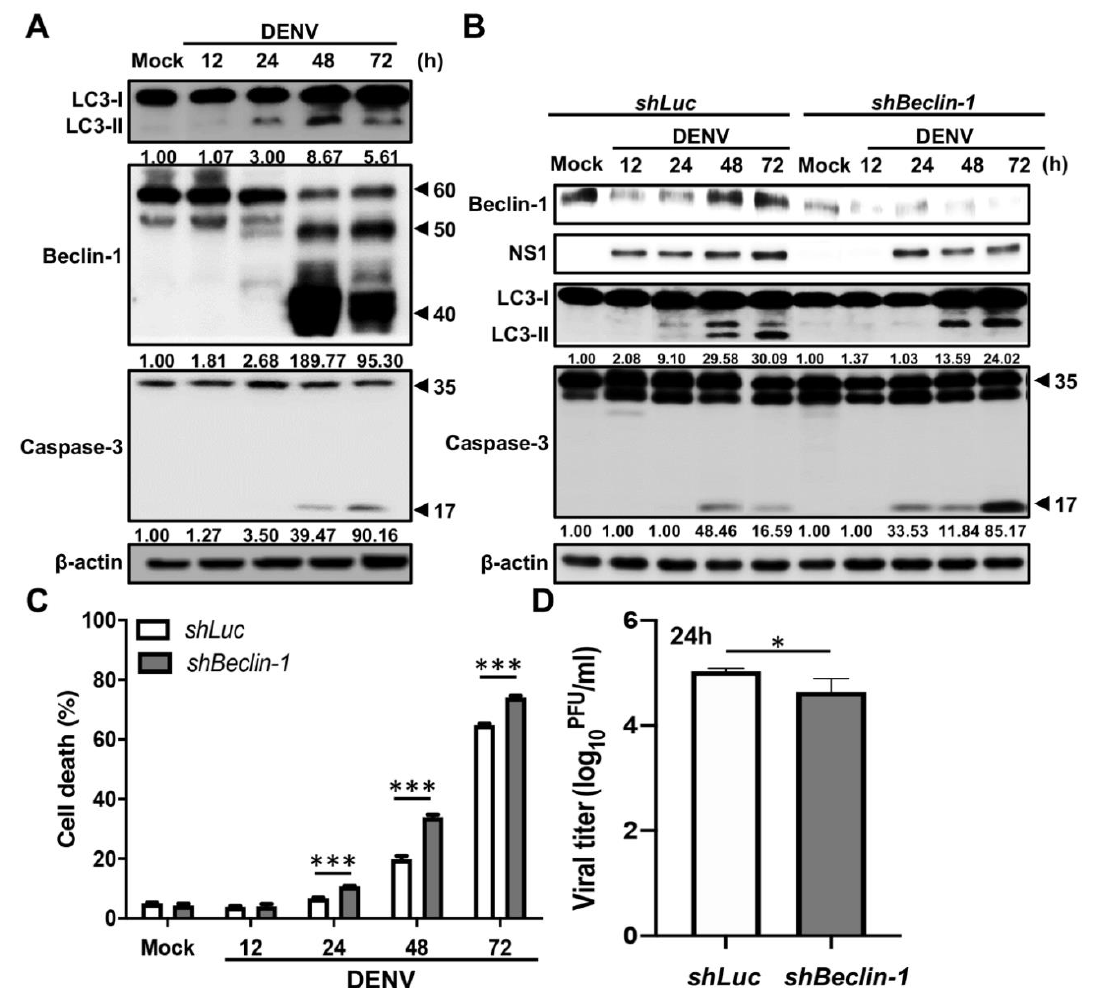
Figure 2. Beclin-1 ablation promotes cell death and inhibits virus production in DENV-infected cells. ( A ) A549 cells were infected with DENV at MOI = 2 for the indicated time. Western blot analysis shows representative images of LC3-I and LC3-II levels, Beclin-1 levels (full-length: 60 kDa, cleaved form: around 50 and 40 kDa), as well as procaspase-3 (35 kDa) and cleaved caspase-3 (17 kDa) levels in mock and DENV-infected cells. β -actin is shown for loading control. The blots were quantified by using β -actin as a calibrated control. The relative ratios (numbers below the blots) of LC3-II, cleaved Beclin-1 (40 kDa) or cleaved caspase-3 to mock were indicated. ( B ) shLuc and shBeclin-1 A549 cells were infected with DENV at MOI = 2 for indicated time. The expression of Beclin-1, NS1, LC3 and caspase-3 was analyzed by Western blotting. β -actin is shown for loading control. The blots were quantified by using β -actin as a calibrated control. The relative ratios (numbers below the blots) of LC3-II or cleaved caspase-3 to mock were indicated. ( C ) The percentage of cell death was determined by propidium iodide staining. Results shown are means ± SD for triplicate cultures. Statistical significance was based on two-way ANOVA followed by Bonferroni’s multiple comparison test. ( D ) The viral titers were determined by plaque assay. Results shown are means ± SD for triplicate cultures. Statistical analysis was performed using a two-tailed Student t -test. All the data are representative of independent experiments. * p < 0.05, and *** p < 0.001.